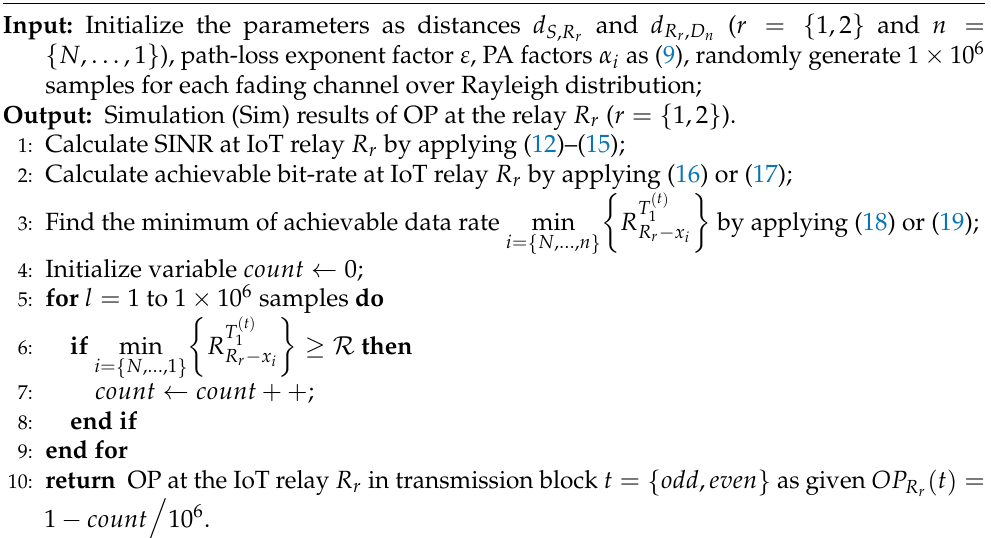
Algorithm 2 The algorithm for investigation OP at IoT relay R r for r = { 1, 2 } in transmis- sion block t = { odd , even